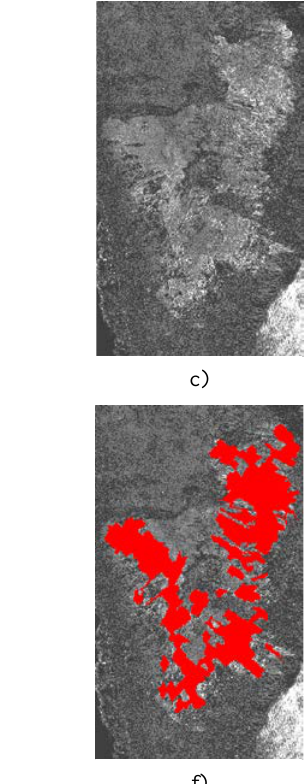
Figure 4 : Study area of La Palma, Spain. Subsets of TerraSAR-X amplitude data (© DLR 2013) of a) 13/12/2007 and b) 09/08/2009, c) intensity ratio image between b) and a), d) classification based on the hypothesis test, e) classification based on the hypothesis test and the graph-cut algorithm, f) classification by Bernhard et al. (2011). In d), e) and f) positive and negative changes are shown in red and blue colors, no-change is